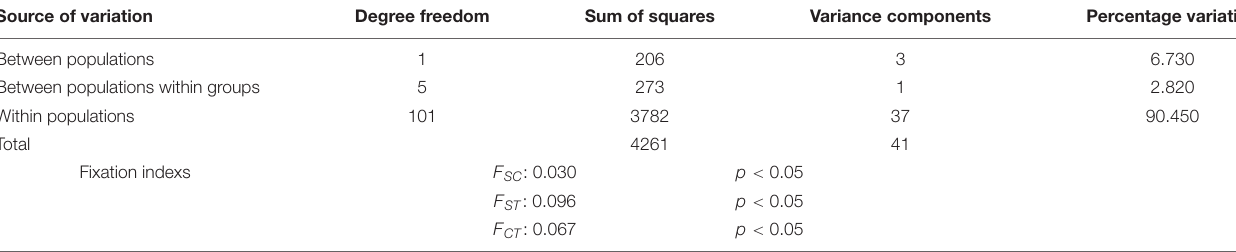
TABLE 2 | Analysis of molecular variance (AMOVA).